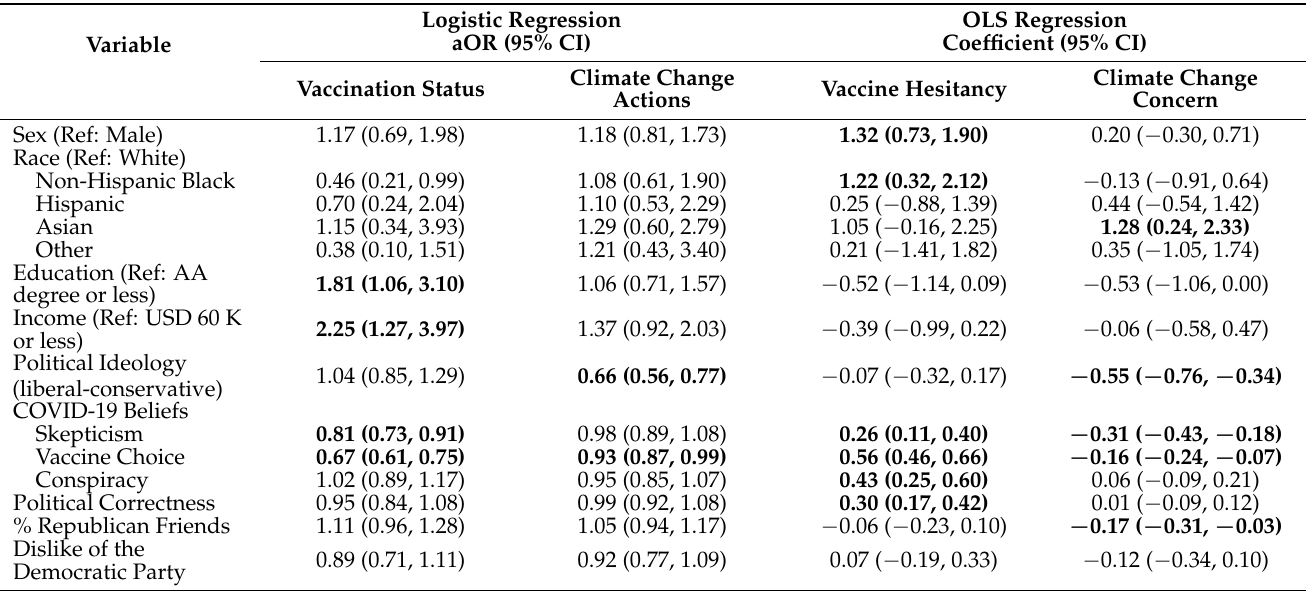
Table 5. Multivariable logistic and OLS regression models of vaccination and climate change attitudes and behaviors, N = 572. Bold = p <